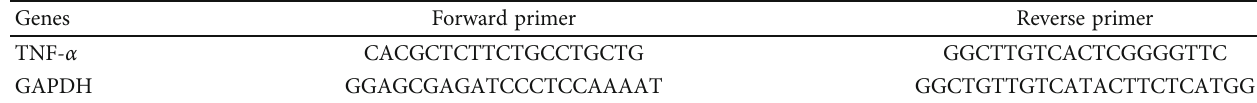
Table 1: Primer sequences of TNF- α and GAPDH.